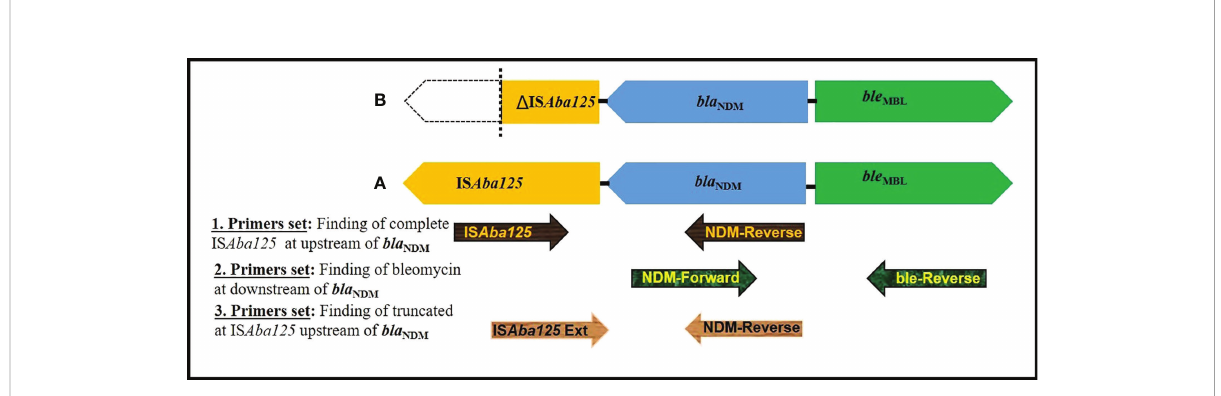
FIGURE 3 Schematic representation of genetic elements surrounding bla NDM. (A) In MIID-C1, MIID-C3, MIID-C4, MIID-C5, MIID-C6, MIID-C7, MIID-C8, MIID-C9, MIID-C12, MIID-C13, MIID-C15, MIID-C16, MIID-C17, MIID-C18, MIID-C20, MIID-C21, MIID-C22, MIID-C23, MIID-C25 and MIID-C26 complete element of IS Aba125 at upstream and bleomycin gene at downstream to bla NDM was found. (B) (MIID-C2, MIID-C19 and MIID-C24, truncated IS Aba125 at upstream and bleomycin gene downstream to bla NDM was found. Arrow indicates the position of primer (used of primers as mentioned in Supplementary Table